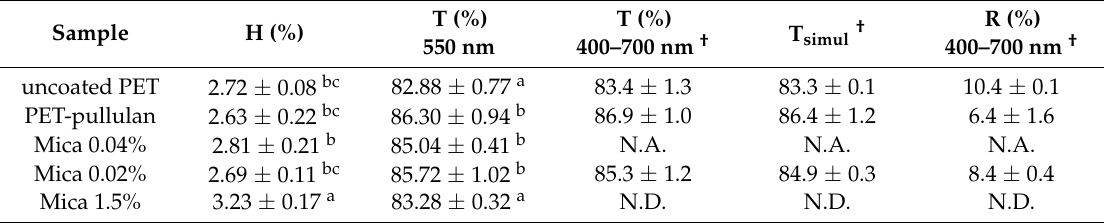
Table 3. Haze (H), transmittance (T), and reflectance (R) of uncoated PET, pullulan-coated PET, and bionanocomposite coatings for different mica concentrations (wt